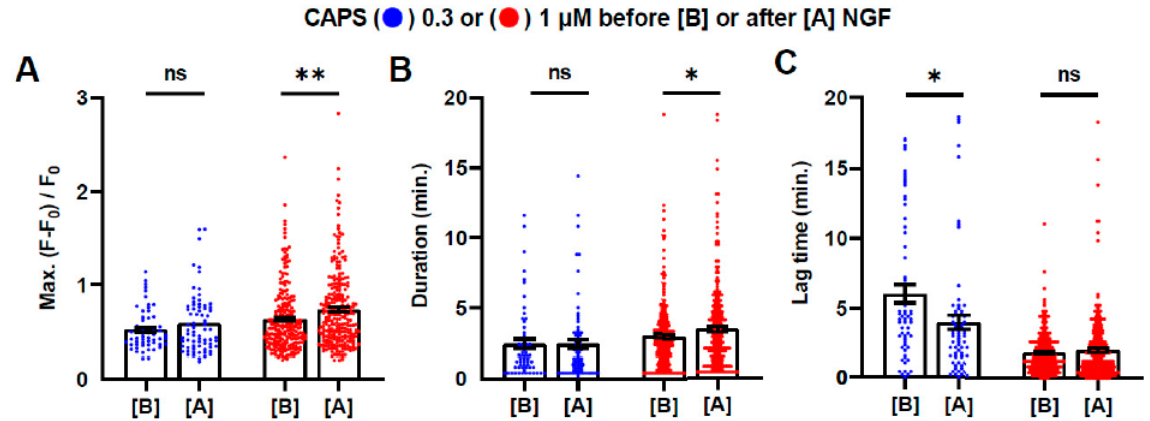
Figure 4. Brief exposure to NGF results in sensitisation to CAPS. Analysis tools were applied to signals evoked by 0.3 (blue dots) and 1 µ M CAPS (red dots) before [B] and after [A] 5 min exposure to 100 ng/mL NGF (blue trace in Figure 1A) to measure ( A ) Max. intensity, ( B ) signal duration and ( C ) lag time. Asterisks represent significance between the measurements before and after NGF treatment, determined by Student’s t-test for unpaired samples, unequal variance; * p < 0.05; ** p < 0.01; ns, not significant. Full statistical analysis is detailed in Supplementary Table S7.